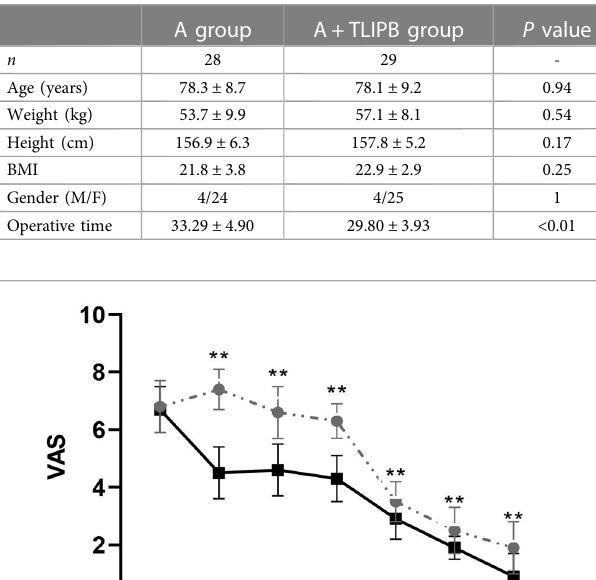
TABLE 1 Baseline characteristics of patients in the two groups.